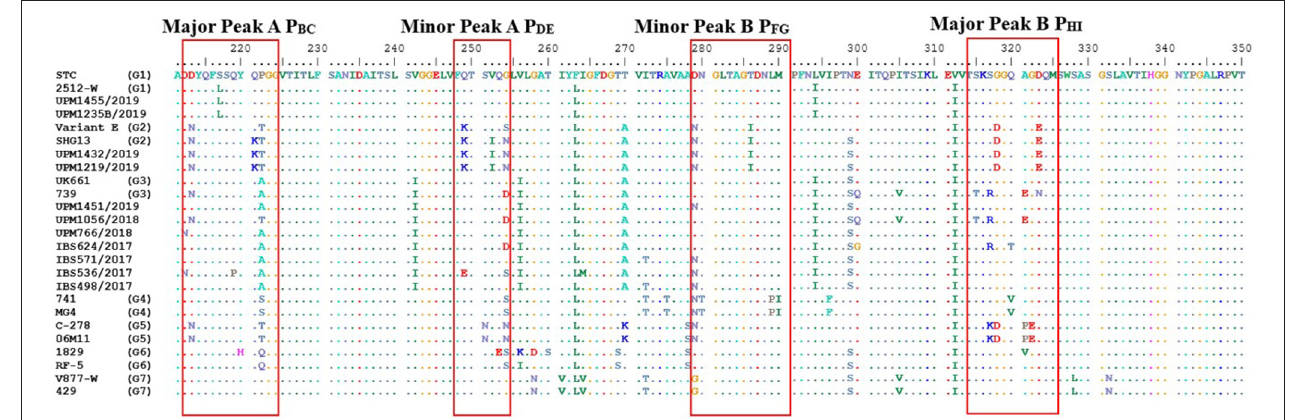
FIGURE 1 | Deduced amino acid sequences of the VP2 hypervariable region from aa position 211 to 350 of IBDV strains. Dots indicate aa positions identical to UPM1455/2019. Major and minor hydrophilic peaks are boxed with a red line.